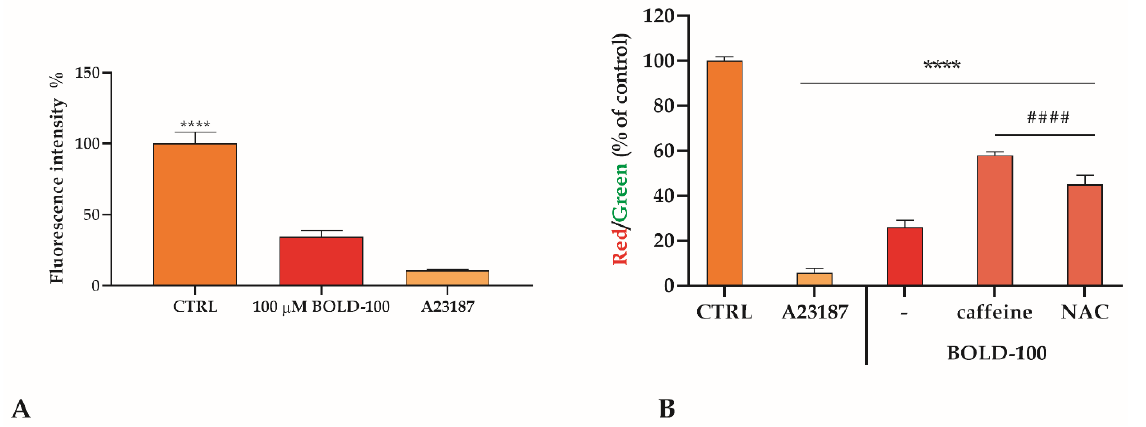
Figure 3. BOLD-100 determines mitochondrial destabilization in REN cells. ( A ). Mitochondrial membrane destabilization evaluated in cells after 1 h exposure to BOLD-100 or ionophore A23187 used as a positive control. Data are means ± SD from five independent treatments, and are expressed as fluorescence intensity%. Statistics indicate differences with respect to the CTRL (**** p < 0.0001, one-way ANOVA followed by Bonferroni correction). ( B ). Mitochondrial membrane potential ( ∆Ψ m) variation assessed in cells after 1 h exposure to BOLD-100 or ionophore A23187 used as a positive control. Data are means ± SD from five independent treatments, and are expressed as a red/green ratio with respect to the % of control. Statistics indicated significant differences with respect to the CTRL (**** p < 0.0001, one-way ANOVA followed by Dunnett’s post-test) or differences between treatment (#### p < 0.0001, one-way ANOVA followed by Sidak’s multiple comparison test).